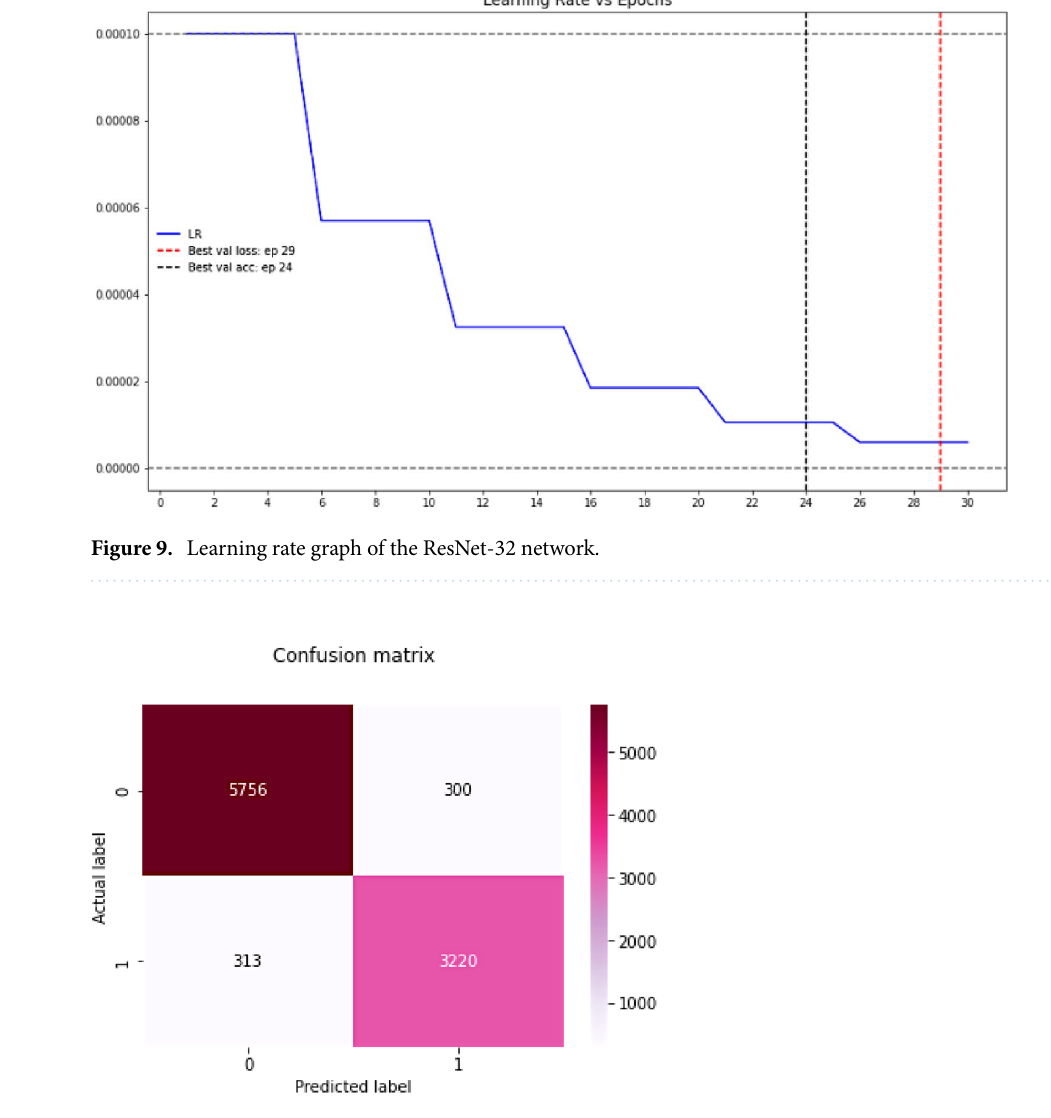
Figure 10. Confusing the matrix of ResNet-32 with